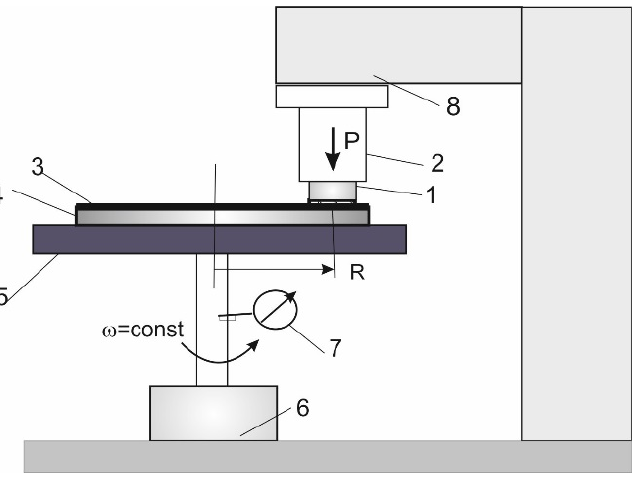
Figure 2. Schematic diagram of abrasive wear testing on pin-disc tribometer.